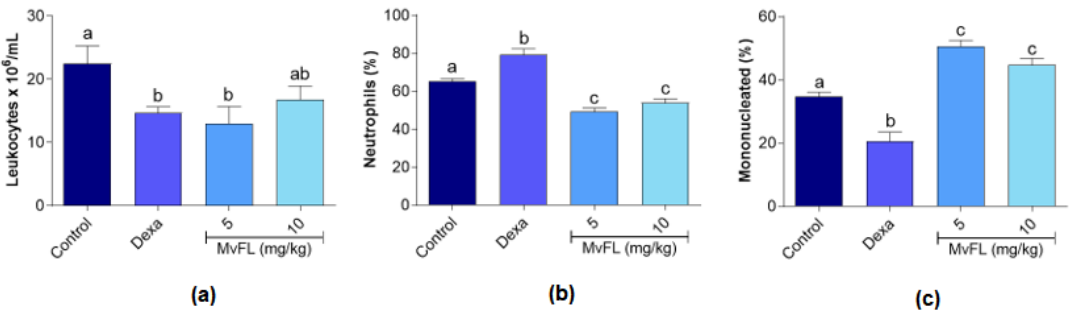
Figure 2. Effects of MvFL (5 and 10 mg/kg) and dexamethasone (2 mg/kg) on leukocyte migration in the peritoneal cavity of mice submitted to carrageenan-induced peritonitis. The graphs show the number of leukocytes per mL ( a ) and the percentage of neutrophils ( b ) and mononucleated cells ( c ) among them. Values are expressed as mean ± standard error of the mean ( n = 6). Different letters above the bars indicate significant ( p < 0.05) differences between treatments according to ANOVA followed by Tukey’s test.